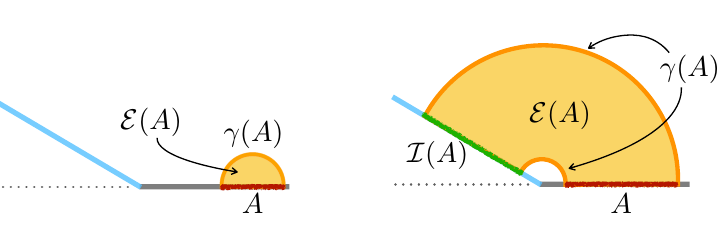
Figure 10 . Two examples of entanglement wedges for a single interval A (shown in red). For simplicity, here we show the projection on a time slice in AdS shown in grey, and the end-of-the-world brane Q is shown in blue. The HRT surface γ ( A ) is shown in orange, and the entanglement wedge E ( A ) is shaded in yellow. In the left panel, γ ( A ) does not touch the brane Q . In the right panel, γ ( A ) touches the brane Q and hence an island I ( A ) (shown in green)